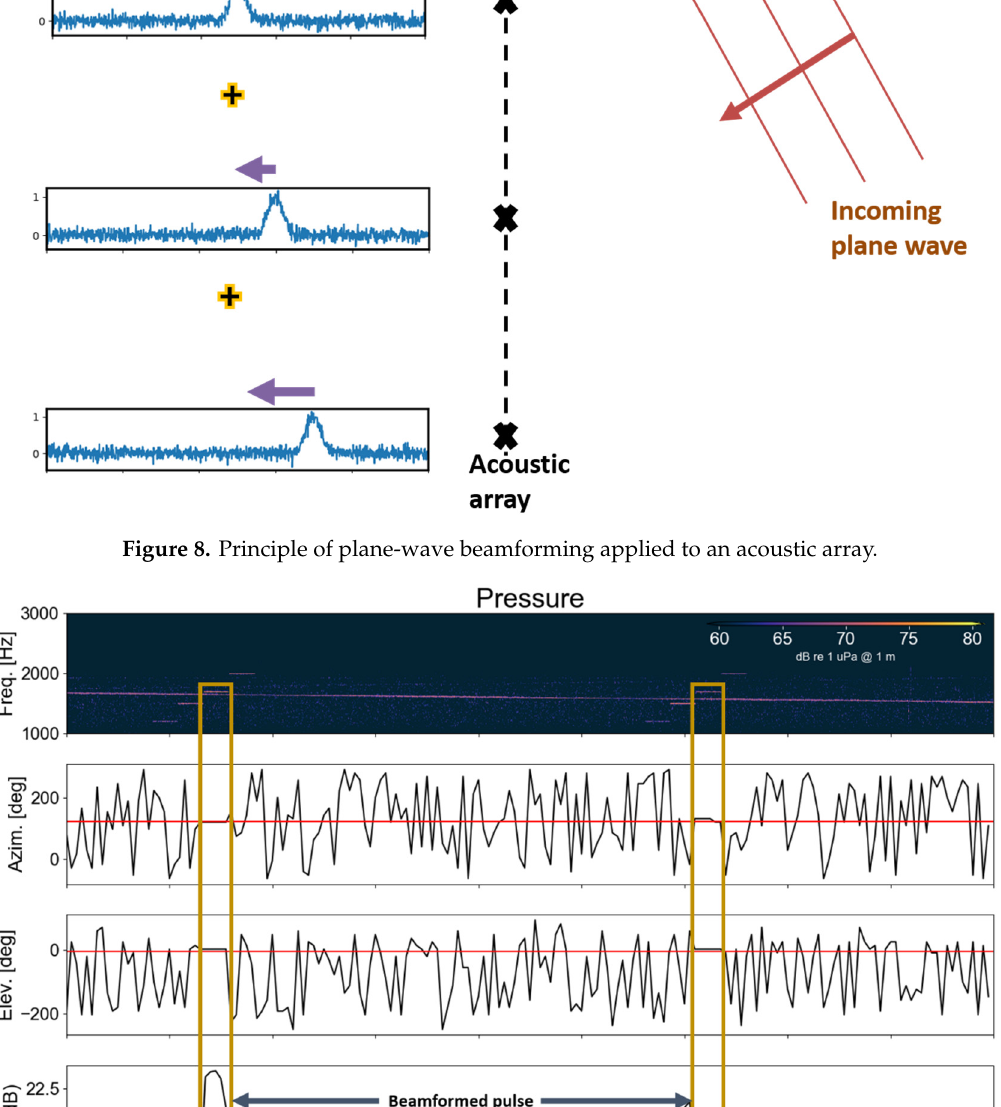
Figure 9. Beamforming location estimation algorithm applied to a 5-min data segment collected in August 2018. Source pulses of interest at 1700 Hz are outlined in orange.